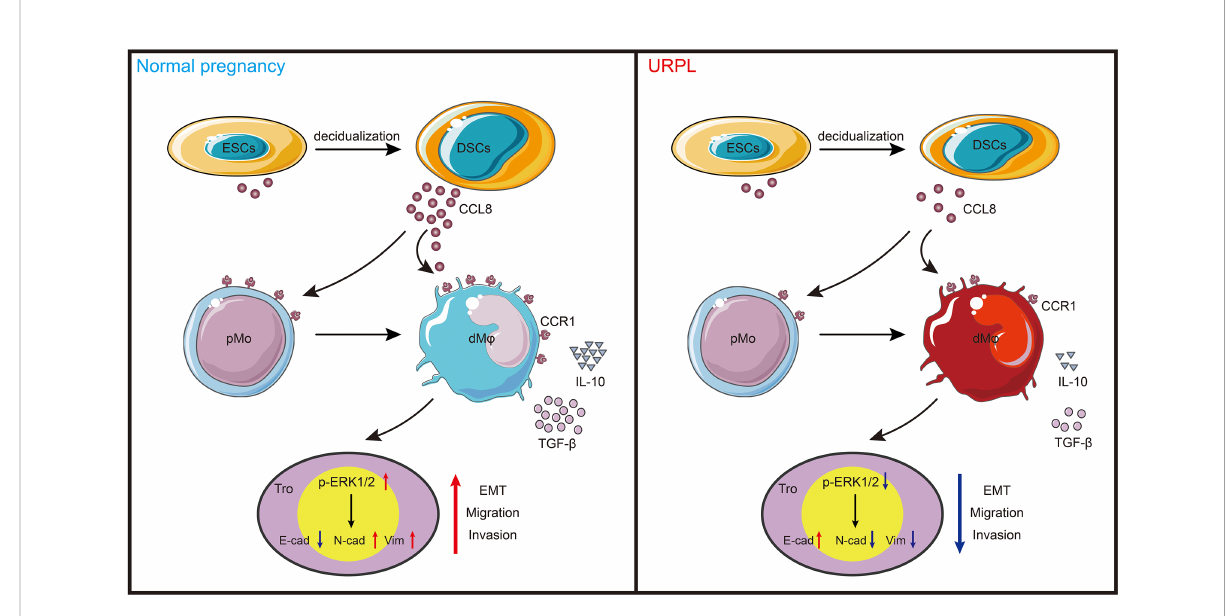
FIGURE 6 Schema of how CCR1 + dM j function at the maternal – fetal interface. CCL8 expression is increased substantially during endometrial decidualization. Through interaction with CCR1, CCL8 attractes CCR1 + pMo from peripheral blood and skews them into a CCR1 + dM j -like phenotype, which displays immunosuppressive phenotype and produces more anti-in fl ammatory cytokines. This crosstalk further supports the migratory and invasive capacities of trophoblasts during EMT by activating the ERK1/2 pathway. Conversely, poor decidualization, characterized by reduced CCL8 secretion, results in decreased number of and dysfunctional CCR1 + dM j , which impair the normal functions of trophoblast cells in women with